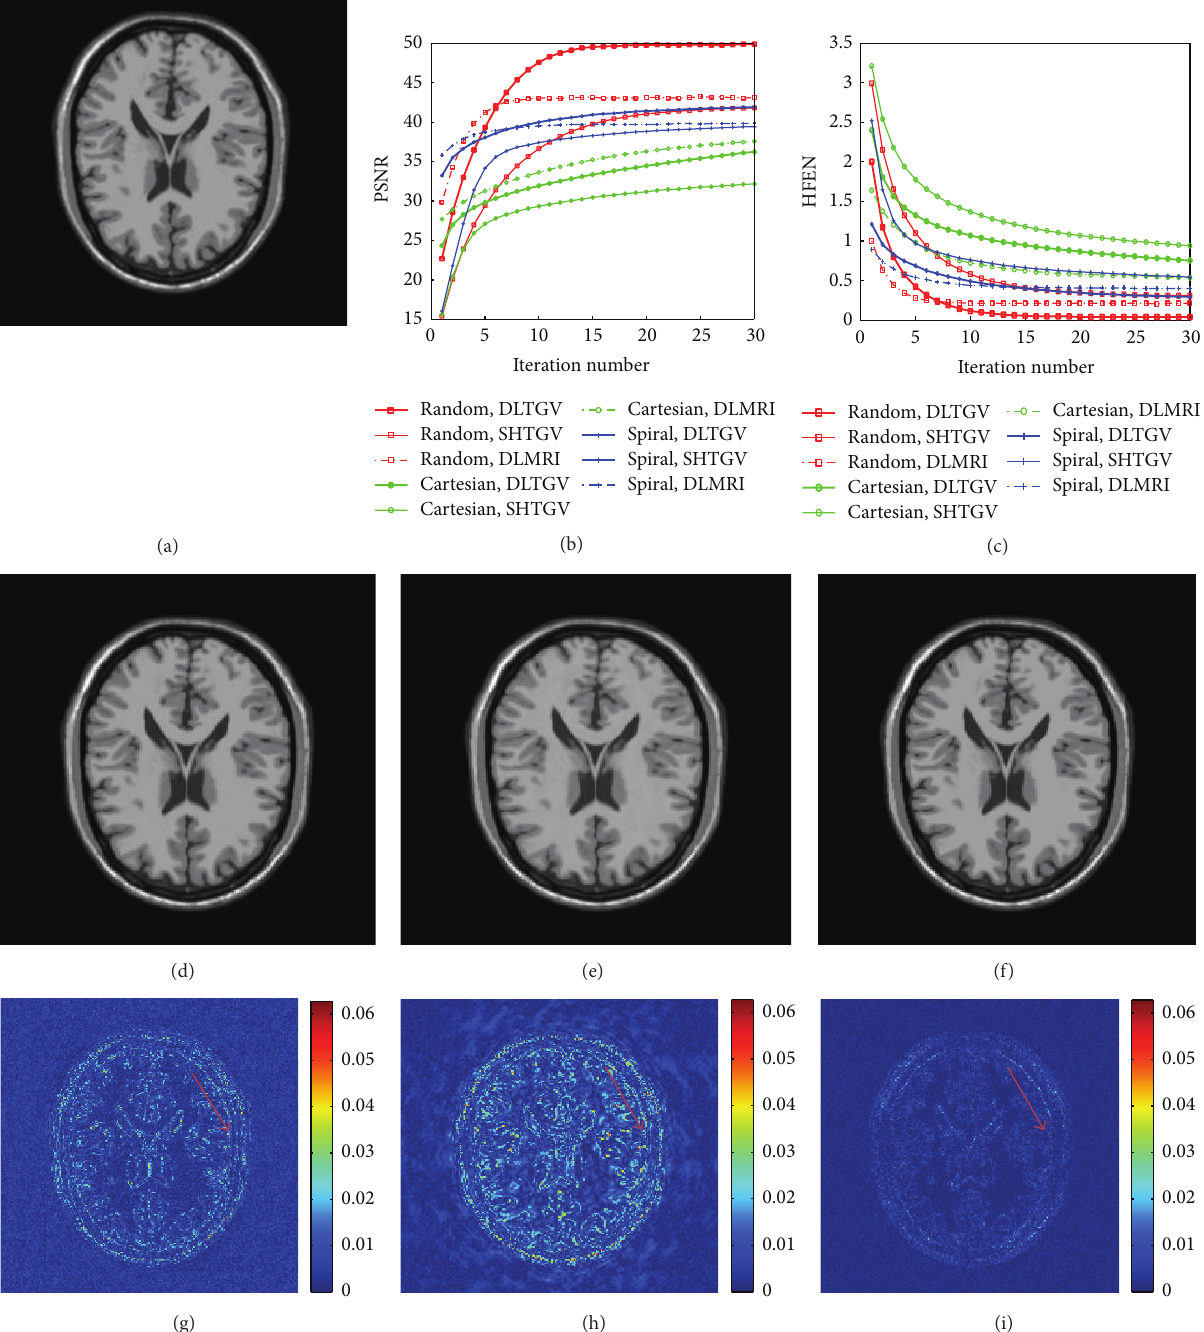
Figure 2: Reconstruction of an axial T2-weighed brain image at 7–11-fold undersampling. (a) The reference image. ((b), (c)) The PSNR and HFEN versus the number of iterations. ((d), (e), (f)) The reconstruction results under 2D random sampling by three methods DLMRI, SHTGV, and DLTGV. ((g), (h), (i)) The corresponding reconstruction error magnitudes of (d), (e), and (f).